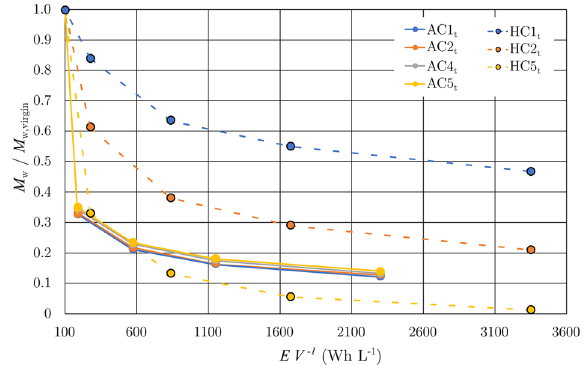
Fig. 5 Energy comparison between time dependent AC and HC treatment of PVOH. AC (solid lines) and HC (dashed lines) treatment for time dependent PVOH degradation. Coloured bullets (AC) and coloured bullets with black line strokes (HC) represent sampling times at 5, 15, 30, and 60 min. Results are presented as ratio between the weight-average molar masses of the treated samples and the virgin PVOH (M w /M w, virgin ) as a function of the calculated energy input per sample volume (E V − 1 ).